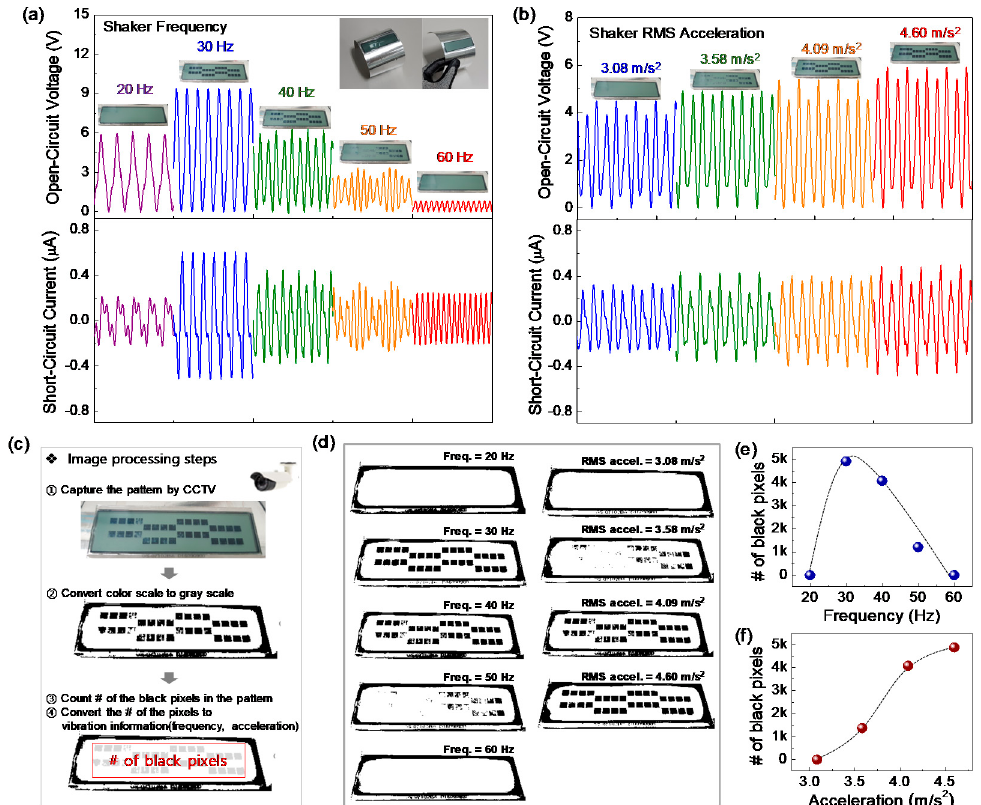
Figure 4. Signal-to-pattern conversion and pattern-to-data reconversion techniques. Signal-to-pattern conversion of a PVV sensor system under various ( a ) frequencies and ( b ) acceleration amplitudes. ( c ) Image processing steps for the pattern-to-data reconversion. ( d ) Color scale to gray scale conversion steps using OpenCV. ( e , f ) Relationship between the numbers of black pixels under various vibration frequencies and acceleration amplitudes.